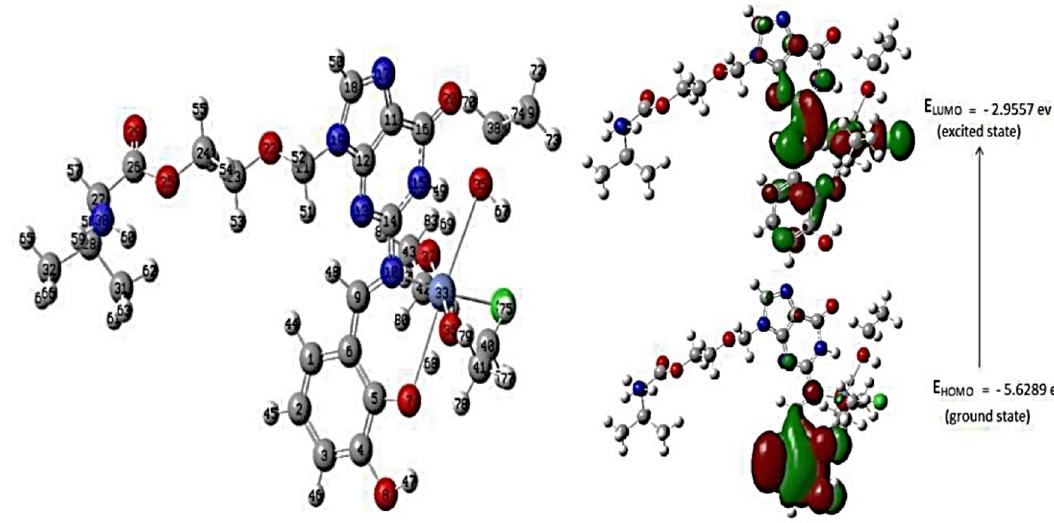
Figure 9. The optimized geometry and HOMO–LUMO energies for the Ni(II) complex 4.